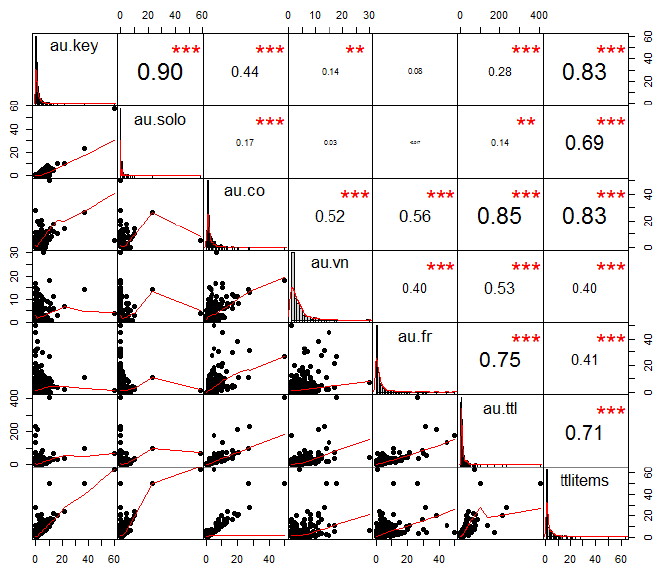
Figure 3. Correlation coefficients in pairs (**,*** denote conventional significance levels at 0.01 and 0.001, respectively).